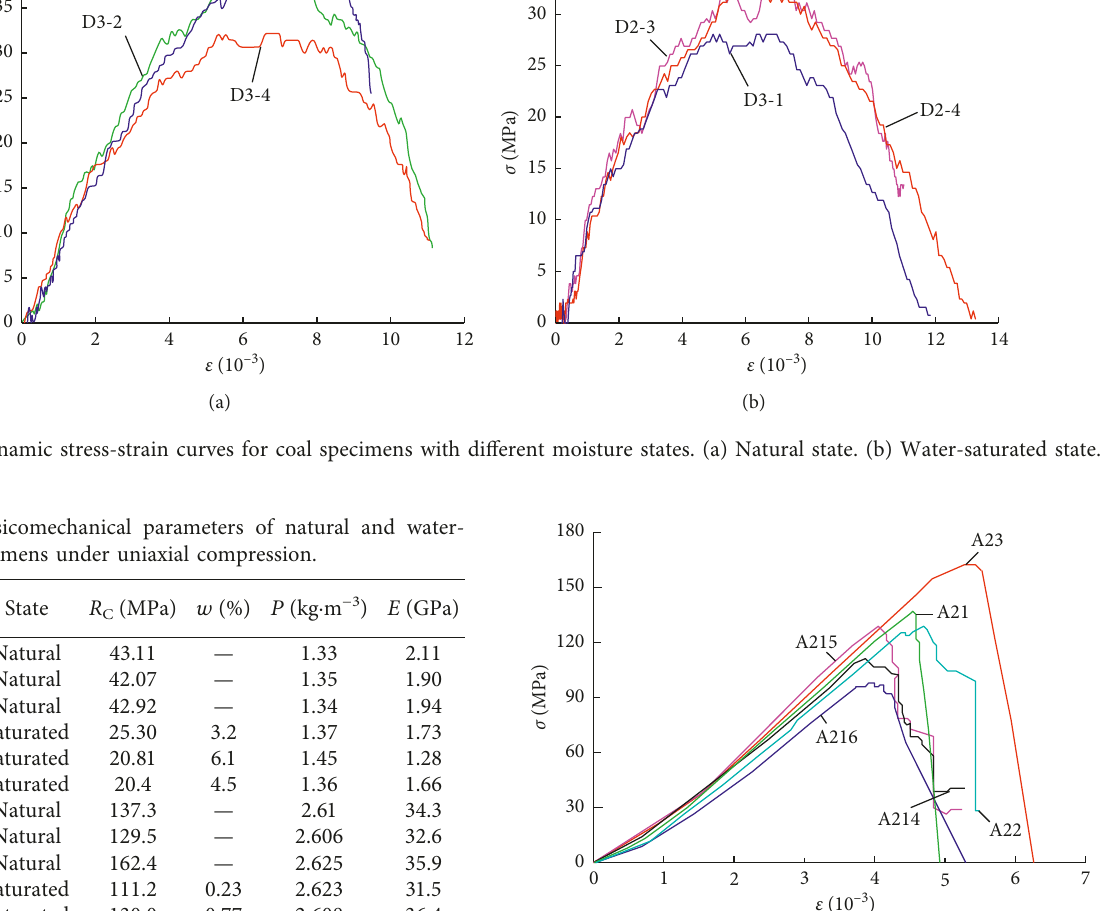
Figure 5: Static stress-strain curves for natural and water-saturated sandstone specimens.